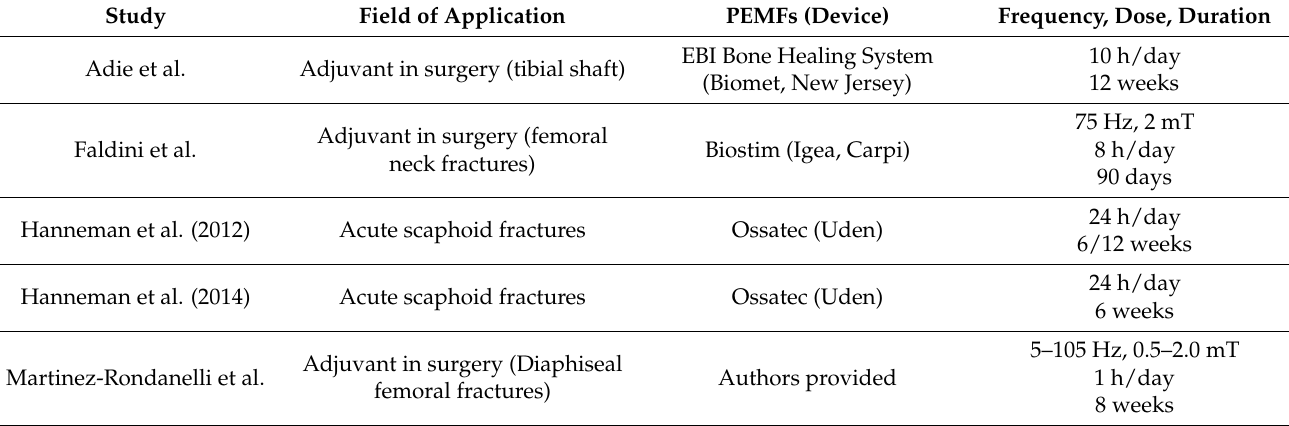
Table 2. Each single study had their parameter in terms of frequency, dose, and duration. Study Field of Application PEMFs (Device) Frequency, Dose,